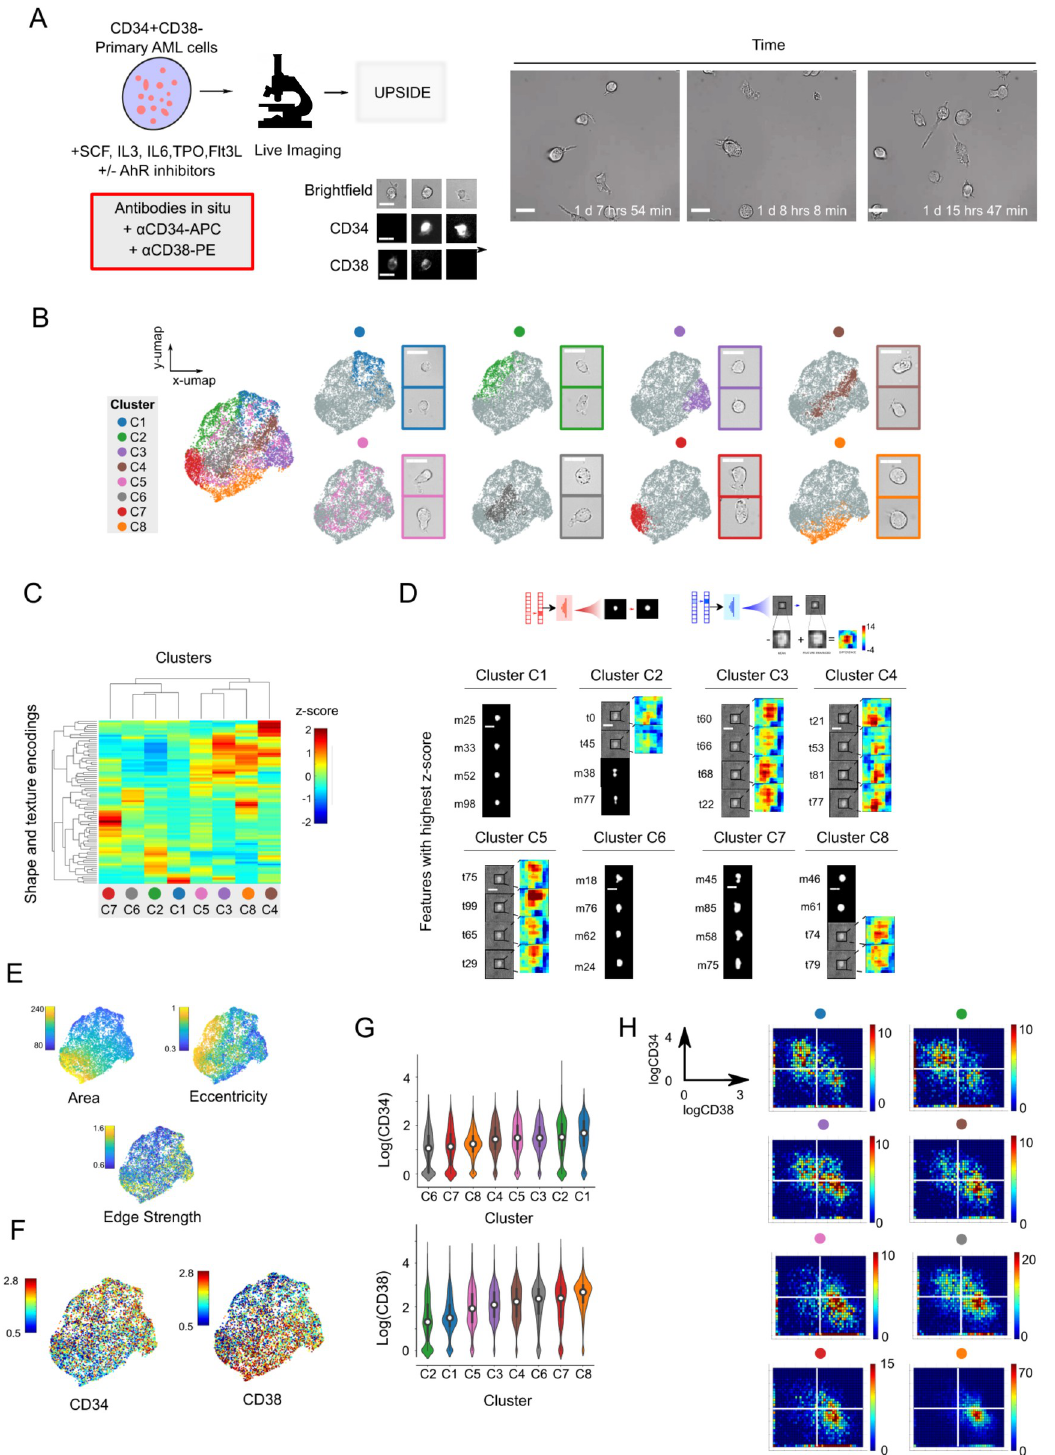
Fig 4. UPSIDE identifies stem cell-associated morphological states from patient-derived AML leukemic cells. (A) LSCs (CD34 + CD38 - ) from an acute myeloid leukemia patient were cultured in cytokines with or without AhR inhibitors (UM729 and StemRegnin1) filmed for ~5 days (left). Brightfield images were captured once every 3-5 minutes. α CD34-APC and α CD38-PE antibodies were added in situ, and fluorescent images were captured once every hour (top right). Still frames show representative time lapse images of AML cells (bottom right). Scale bar represents 10 μ m. (B) UMAP 2D projection of the UPSIDE generated latent space